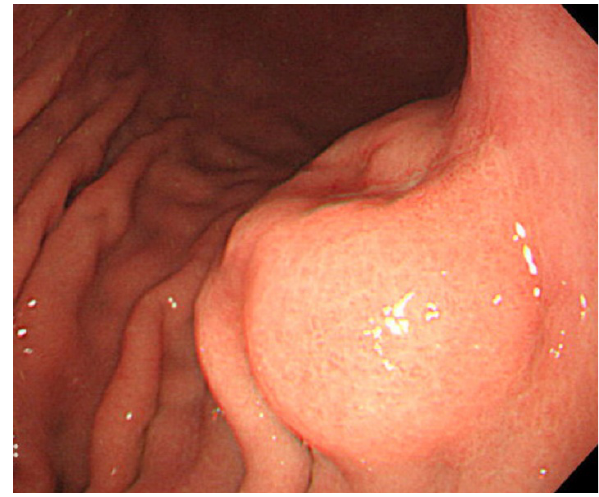
Figure 2. Endoscopic image of an early EBVaGC in the upper gastric body. The tumor shows protruded shape probably because of the abundant lymphocyte